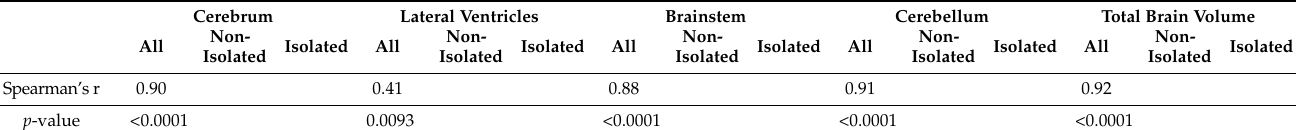
Table 2. Three-dimensional MRI biometric fetal brain